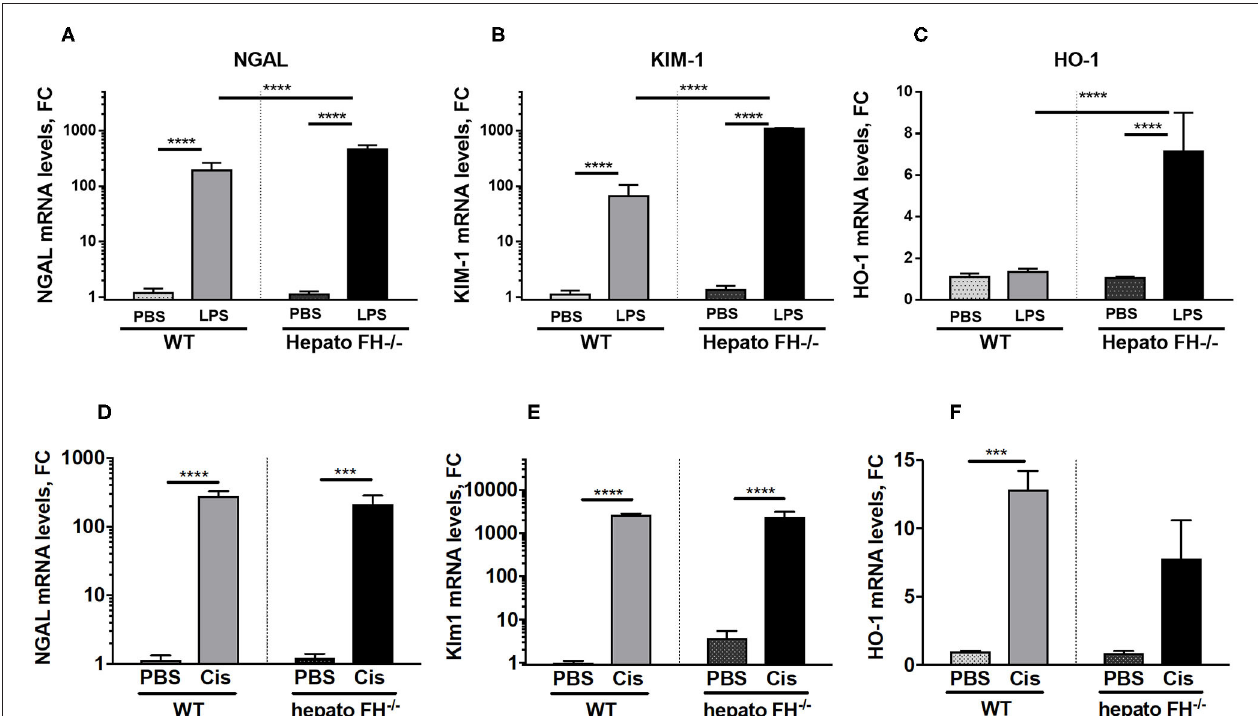
FIGURE 3 | LPS-induced but not Cisplatin-induced tubular injury is exacerbated by FH deficiency. WT and hepatoFH − / − received intraperitoneal injection of PBS, cisplatin (15 mg/kg) or LPS (LPS-EB from E. coli O111:B4) (2 mg/kg) at Day 0 and were sacrificed at Day 2. Renal mRNA expression in LPS treated mice of NGAL (A) , Kim-1 (B), and HO-1 (C) or Cisplatin treated mice of NGAL ( Lcn2 ) (D) , Kim-1 ( Havcr1 ) (E) and HO-1 ( Hmox1 ) (F) were measured by RTqPCR. P- values are derived from two way ANOVA with Sidak correction: *** P < 0.0005; **** P < 0.0001. Values are mean + /- SEM. Cis, cisplatin. Data from two independent experiments, experimental group containing between 2 and 5